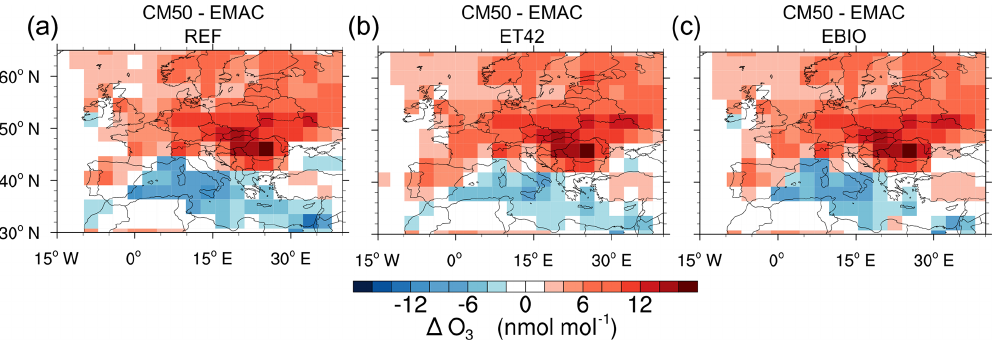
Figure 3. Difference (in nanomoles per mole) between JJA average ozone mixing ratios from 2008 as simulated by CM50 and EMAC (“CM50 − EMAC”). (a) REF simulation, (b) ET42 simulation, and (c) EBIO simulation.